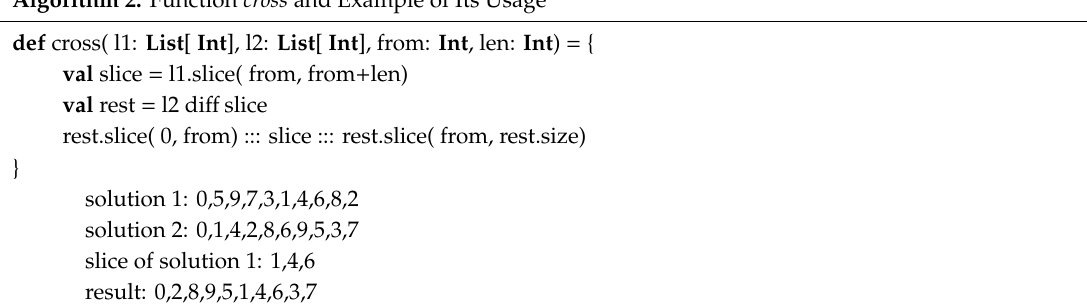
Algorithm 2. Function cross and Example of Its